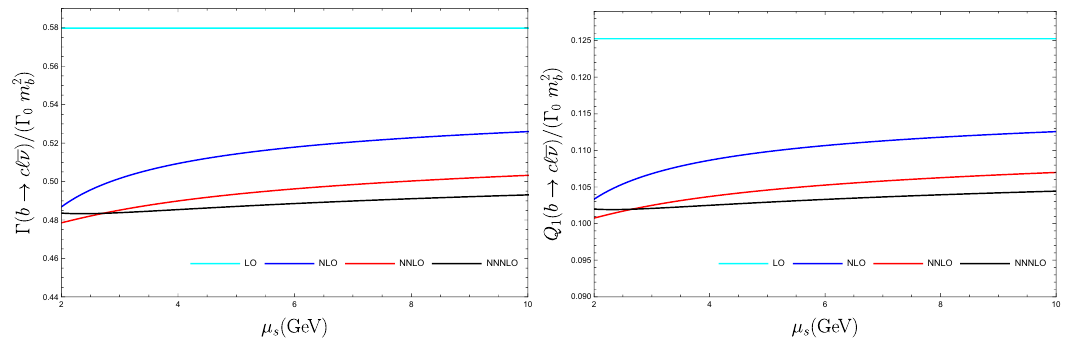
Figure 3: The dependence on µ of the total rate Γ (left) and the first q 2 -moment Q s (right) for different orders in the strong coupling constants with the bottom quark expressed in the kinetic scheme and the charm mass in the MS scheme. The scale of = the charm quark is set to µ c